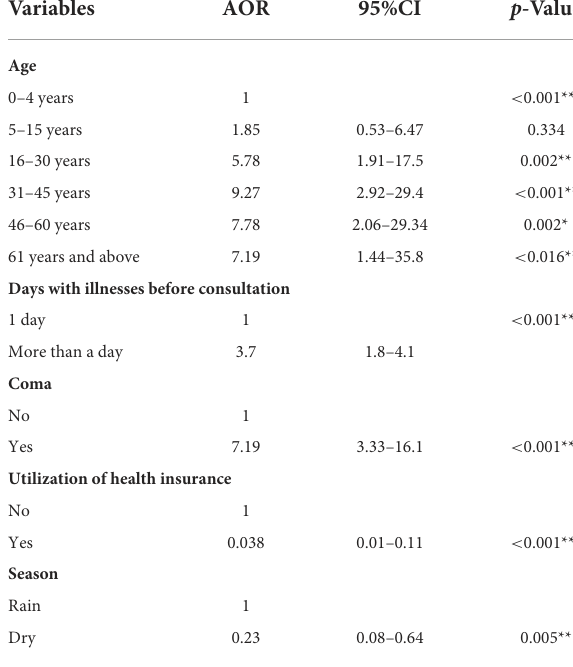
TABLE 4 Factors associated with death among the patients with